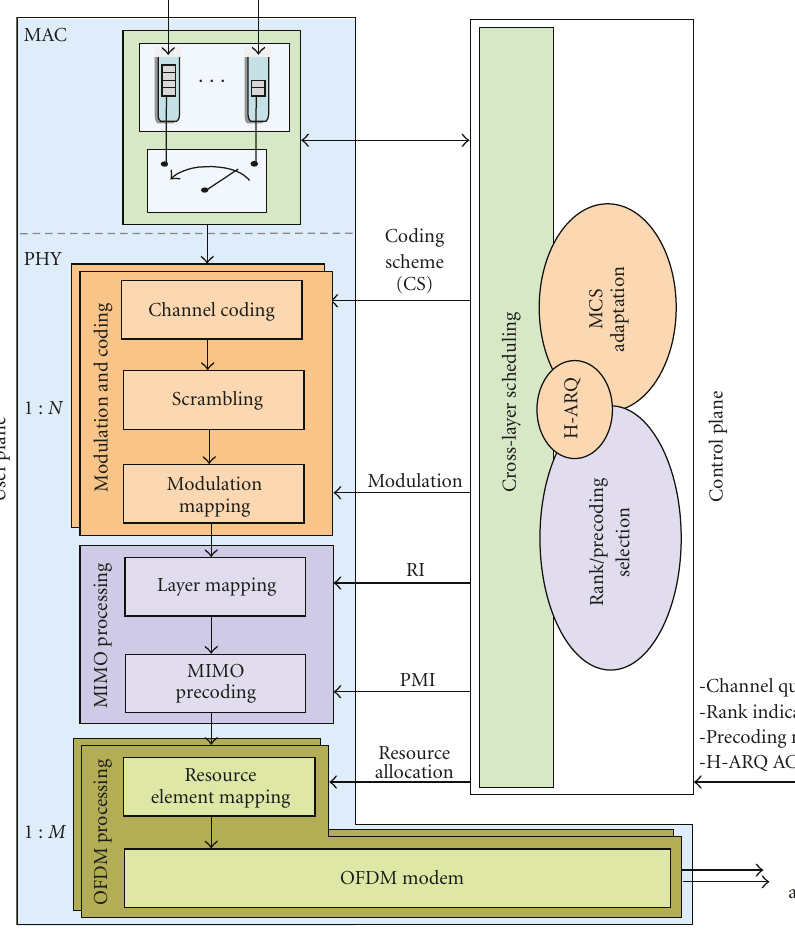
Figure 2: Base Station Architecture